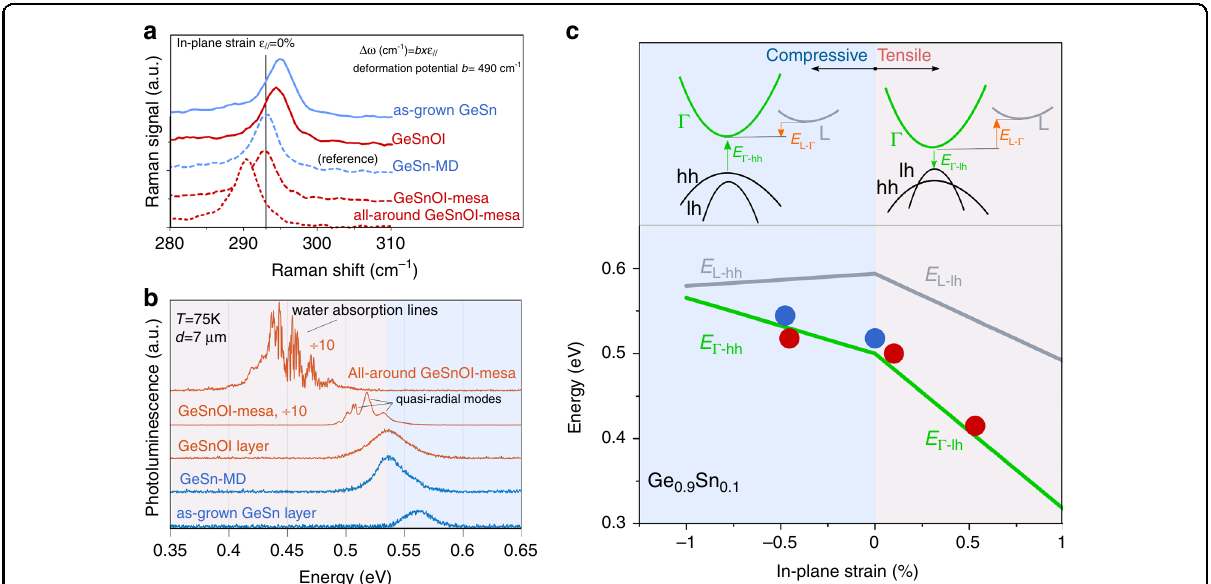
Fig. 2 Optical analysis of strain. a Raman spectra of LO-phonon vibrations in the blanket, as-grown GeSn 10.5% on Ge SRB stacks, blanket GeSnOI stacks, GeSn-on-Ge SRB microdisks, GeSnOI mesas, and all-around GeSnOI mesas. The diameter of disks and mesa was 7 µm. b Photoluminescence spectra of GeSn layers as in ( a ) excited with cw optical pumping. c Direct and indirect bandgap energies of GeSn as a function of strain. Direct bandgap energies from PL measurements appear as blue circles for the as-grown GeSn 10.5% on Ge SRB stack and the GeSn-on-Ge SRB microdisks. Red circles show the PL energies for the blanket GeSnOI stack, the GeSnOI mesa, and the all-around GeSnOI mesa (from left to right). Full lines are calculated direct bandgap (green) and indirect bandgap (gray) energies as functions of strain using model as described in ref. 5 . The top picture is a schematic scenario of band structure for compressive and tensile-strained